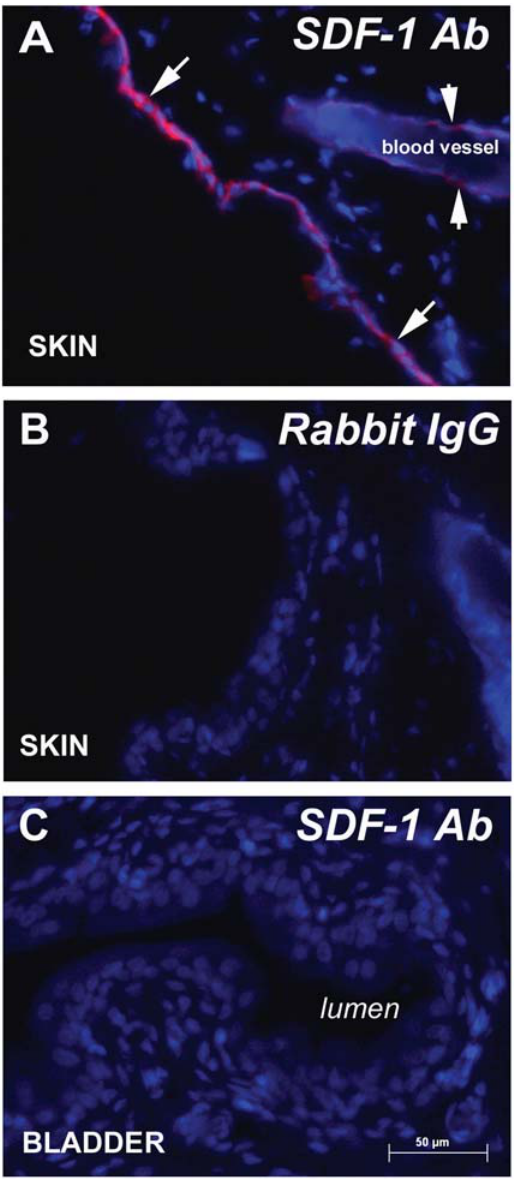
Figure 4. SDF-1 immunostaining. A) SDF-1 immunostaining was observed in keratinocytes (arrows) and endothelial cells in blood vessels (short arrows) in skin. B) Omission of primary antisera eliminated immunostaining. C) Bladder sections did not show SDF-1